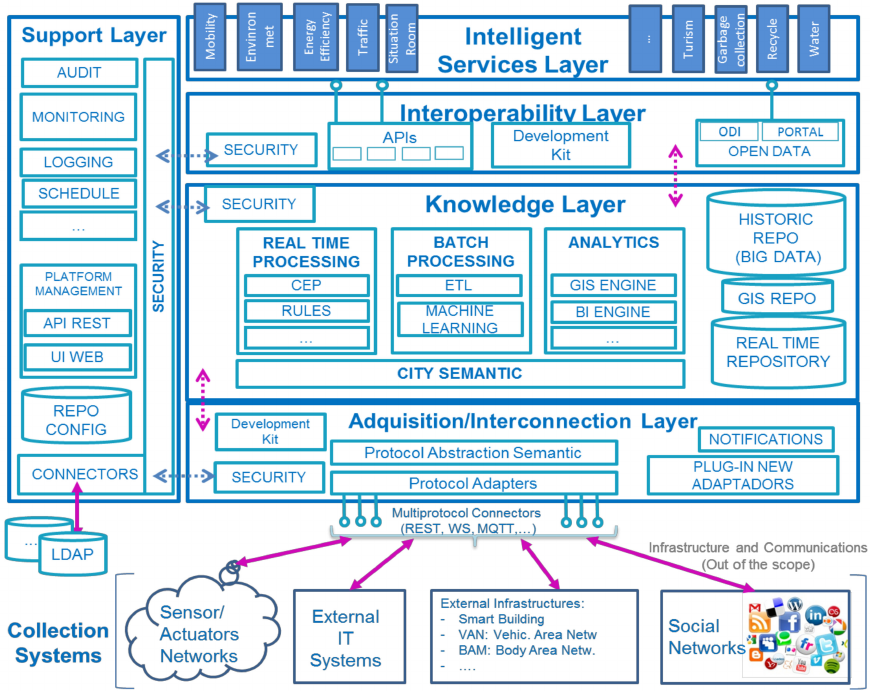
Figure 1. ITU-T (International Telecommunication Union) reference architecture for Smart City Urban Platforms.